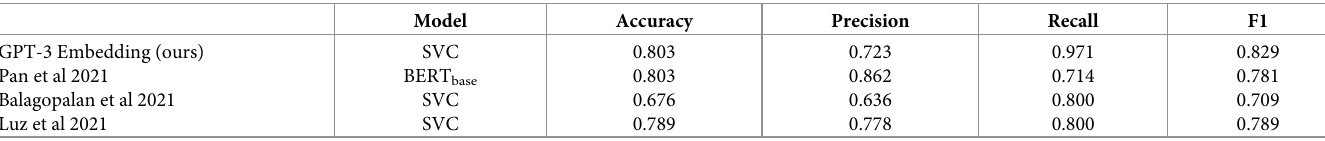
Table 5. Performance comparison between our model and other models on the ADReSSo 2021 unseen test